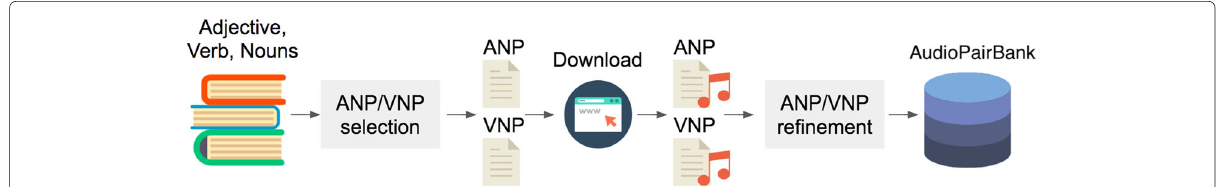
Fig. 1 Dataset construction. An overview of the collection process of AudioPairBank. The ANP and VNP labels are based on existing ontologies. The labels are used as queries to download audio from freesound.org . The labels and audio recordings were refined to create the final version of